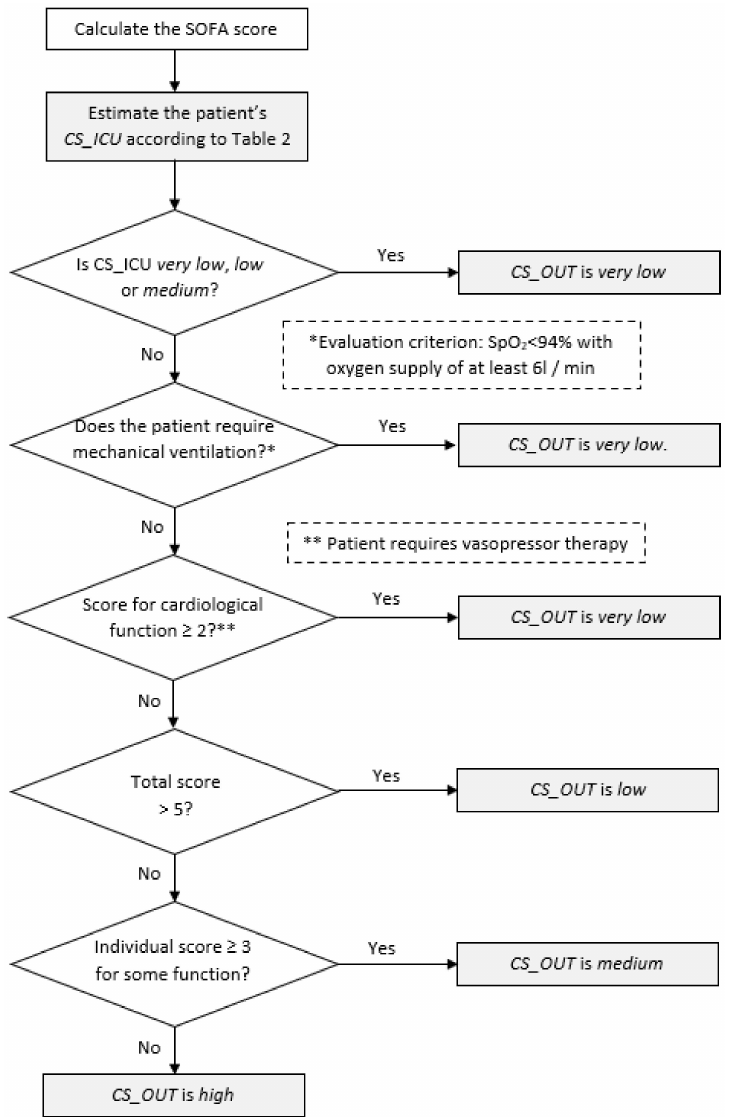
Figure 2. Estimation of the patient’s chance of survival outside the ICU. CS_ICU —chance of survival during the stay in the ICU, CS_OUT —chance of survival outside the ICU. SpO 2 —blood oxygen